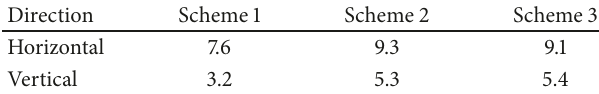
Table 2: Extreme value of acceleration (unit: m/s 2 ). Table 3: Extreme value of dynamic displacement (unit: